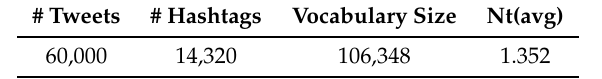
Table 1. Statistics of the dataset, Nt(avg) is the average number of hashtags in the Twitter dataset. # Tweets # Hashtags Vocabulary Size Nt(avg) 60,000 14,320 106,348 1.352